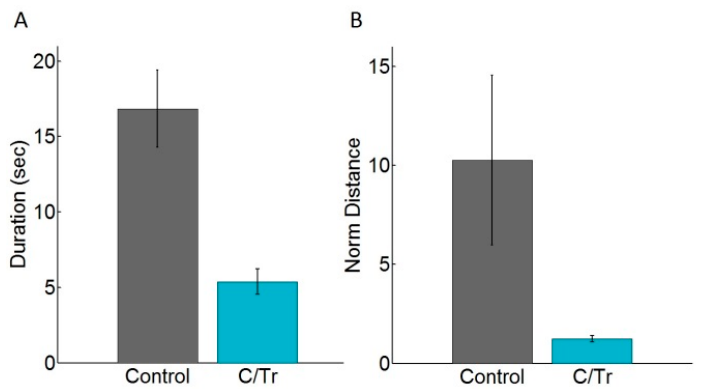
Figure 6. Visual search performance ( A —Duration and B —Distance ratio) with and without tactile cues. The control condition is represented in grey. The tactile condition (C / Tr; see Study 1) is represented in cyan.